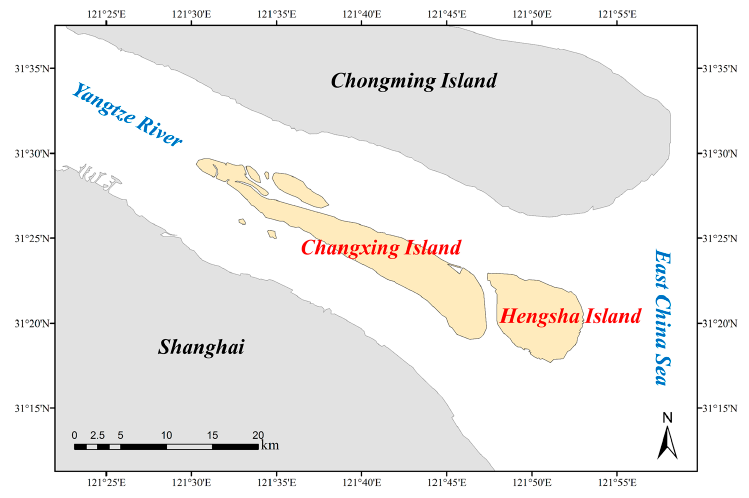
Figure 1. Geographical location of Changxing Island and Hengsha Island, Shanghai, China.